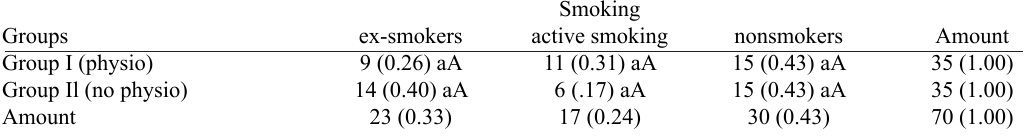
Table 2. Number and proportion of patients in each group according to the presence of active smoking, ex-smokers and